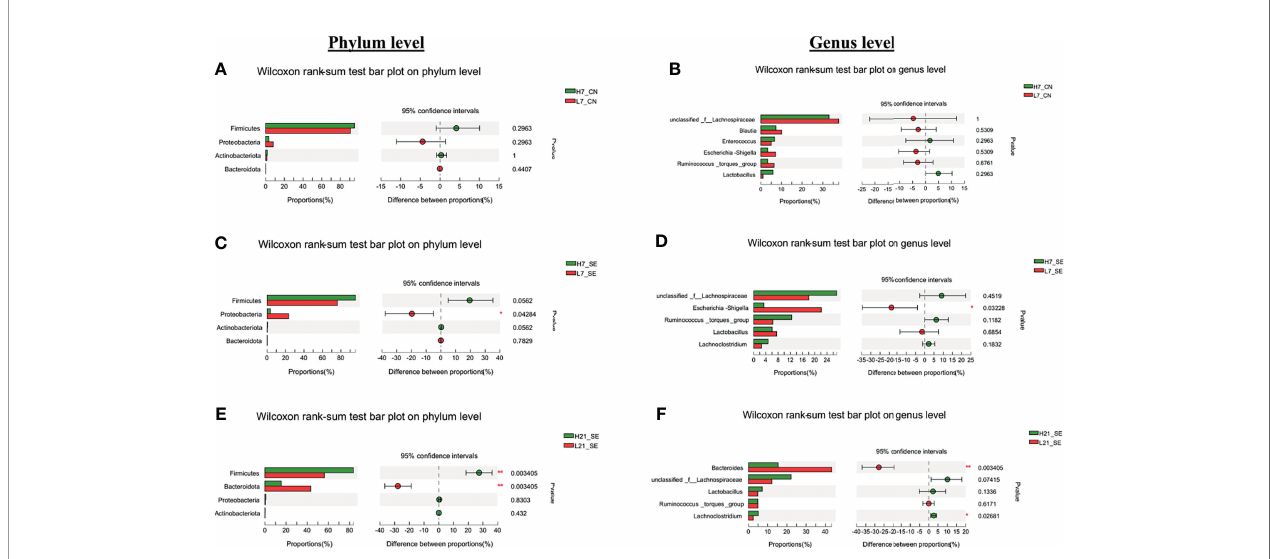
FIGURE 6 | Comparative analysis of relative abundance of cecal microbiota phyla and genera. (A) Cecal microbiota phyla differential abundance between high and low H/L ratio non-infected chickens at 7 dpi. (B) Cecal microbiota genera differential abundance between high and low H/L ratio non-infected chickens at 7 dpi. (C) Cecal microbiota phyla differential abundance between high and low H/L ratio SE-infected chickens at 7 dpi. (D) Cecal microbiota genera differential abundance between high and low H/L ratio SE-infected chickens at 7 dpi. (E) Cecal microbiota phyla differential abundance between high and low H/L ratio SE-infected chickens at 21 dpi. (F) Cecal microbiota genera differential abundance between high and low H/L ratio SE-infected chickens at 21 dpi. Data analyzed by Wilcoxon rank-sum test, with reported p-value and signi fi cances. H7_CN: high H/L non-infected 7 dpi (n = 5); L7_CN: low H/L non-infected 7 dpi (n = 5); H7_SE: High H/L SE-infected 7 dpi (n = 8); L7_SE: Low H/L SE-infected 7 dpi (n = 7); H21_SE: high H/L SE-infected 21 dpi (n = 6); L21_SE: Low H/L SE-infected 21 dpi (n =